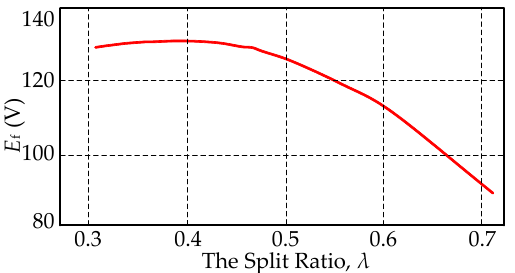
Figure 14. The back EMF is a function of the split ratio λ.